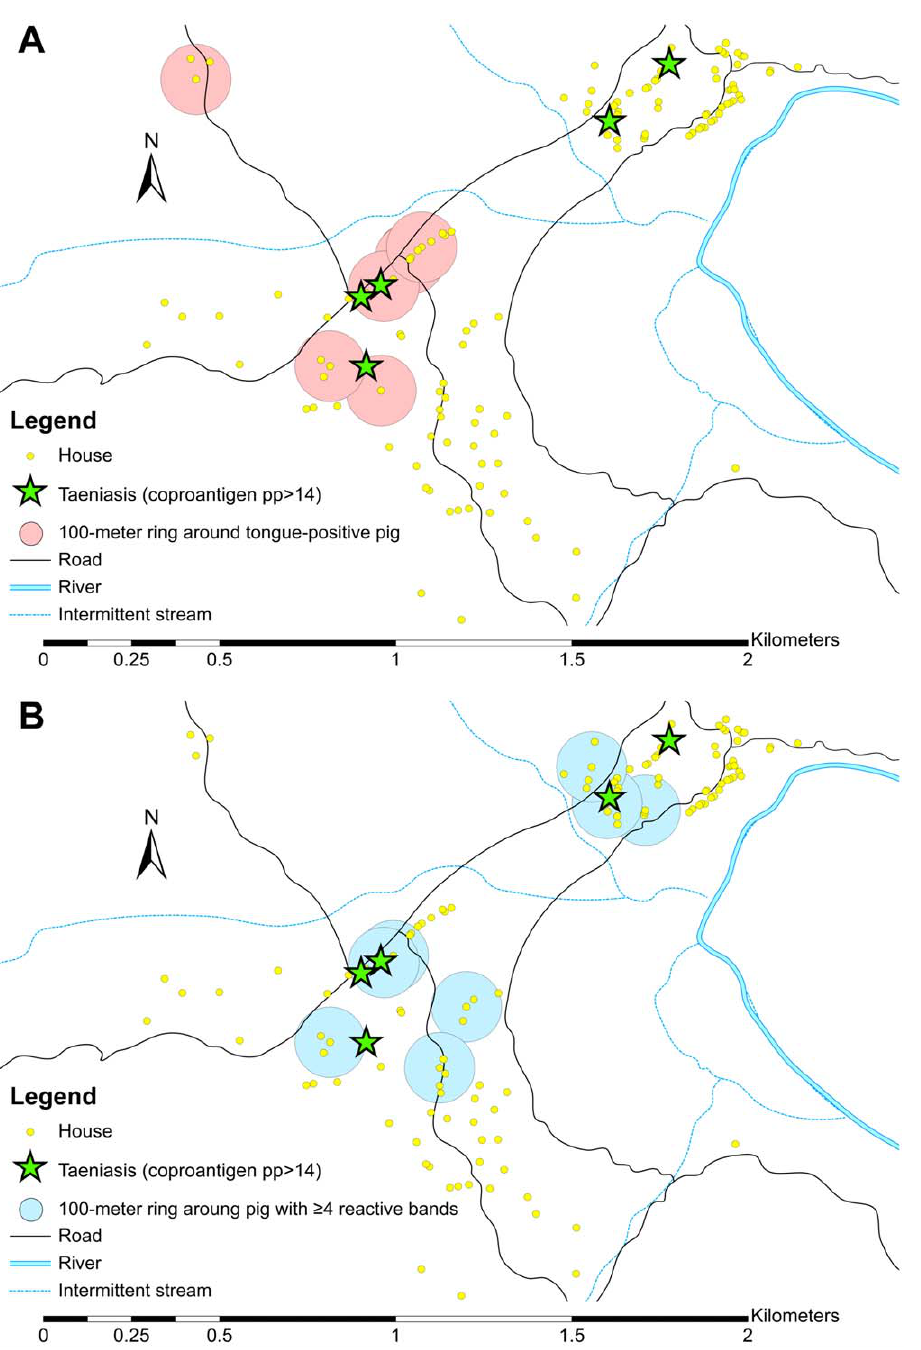
Figure 2. Maps of Rica Playa, Tumbes, Peru, showing the geographic locations of people with taeniasis and heavily-infected cysticercotic pigs. Green stars indicate the 5 households in which 6 coproantigen-positive individuals resided. A. Red circles indicate 100-meter ring radius around households where a tongue-positive pig was raised. There were 11 tongue-positive pigs raised in 7 different households (2 overlap on map). B. Blue circles indicate 100-meter ring radius around households where a seropositive pig with more than 4 reactive bands on EITB LLGP was raised. There were 8 pigs with 4 + reactive bands in 8 separate households.